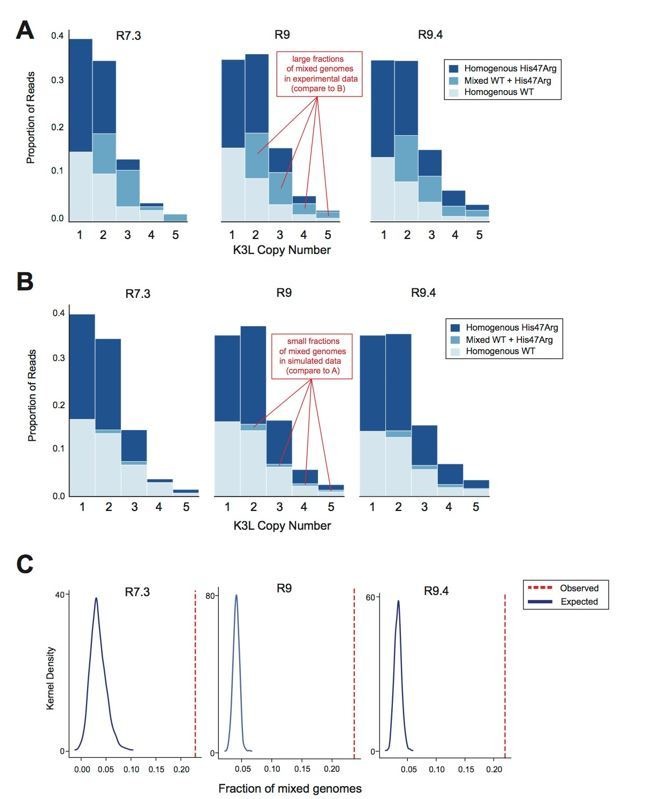
Oxford Nanopore sequencing error does not impact observed patterns of K3L copy number or K3LHis47Arg allele heterogeneity.The P15 vaccinia population was sequenced with R7.3, R9, and R9.4 chemistry ONT flowcells. (A) Stacked bar plots representing the diversity of allele combinations within single-copy and multicopy reads were generated from sequenced ONT reads from each chemistry, as in Figure 3 and Figure 5 (original manuscript). (B) All mixed genomes observed in the data from each flowcell chemistry were converted to homogeneous genomes (Extended Methods), and sequencing errors were randomly distributed throughout these genomes at a rate equivalent to the median C>T or T>C error rate for the particular chemistry (see Response Table 1). Stacked bar plots representing the resulting diversity of allele combinations were then created as in (A). (C) We performed the simulation in (B) a total of 1000 times, and generated kernel density plots representing the distribution of mixed genome proportions recovered in each simulation. The red line indicates the proportion of mixed genomes observed in the experimental data for the sequencing chemistry of interest..